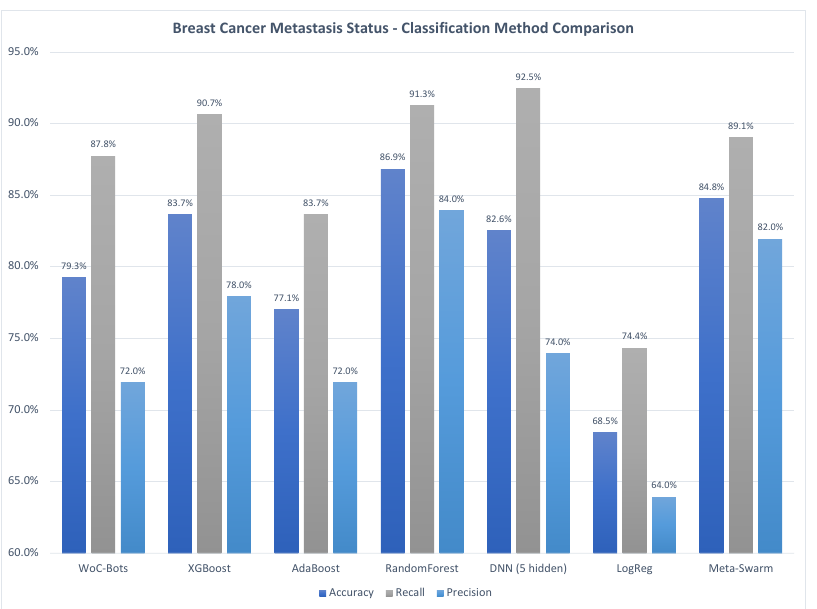
Figure 2. Comparison of five classification methods with two versions of the swarm (first and last columns) for the breast cancer